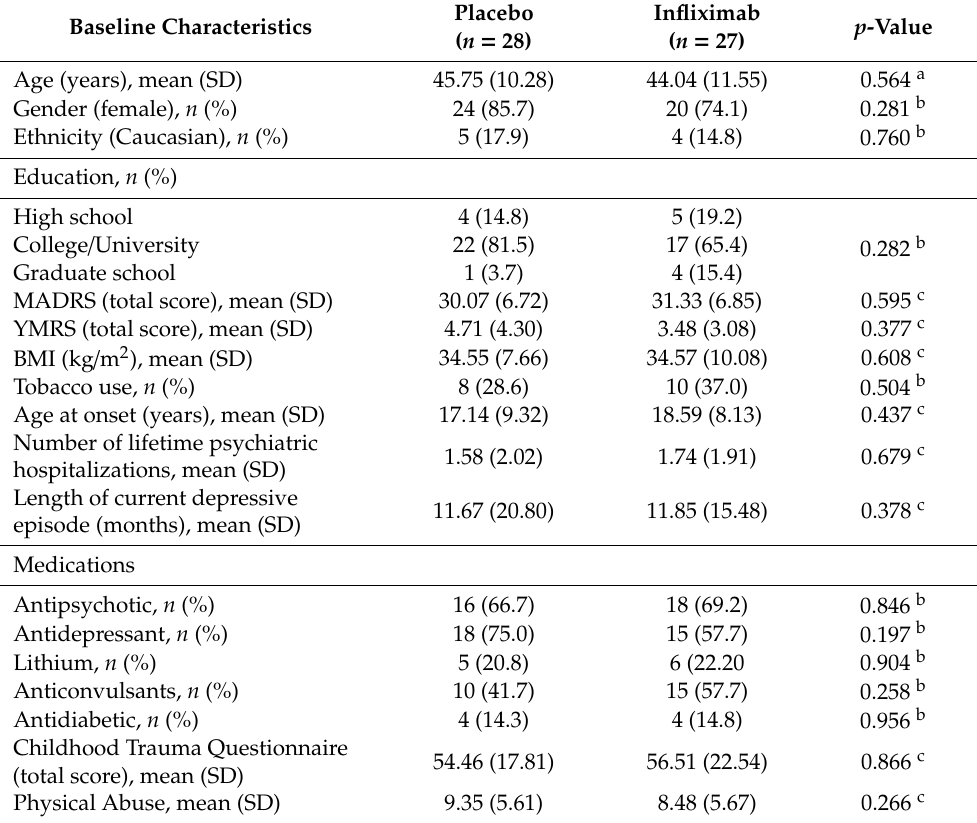
Table 1. Sample baseline characteristics of the intent-to-treat